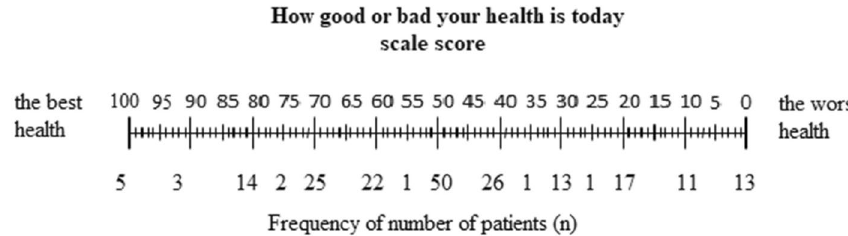
Fig. 2 The frequency distribution of “How good or bad your health is